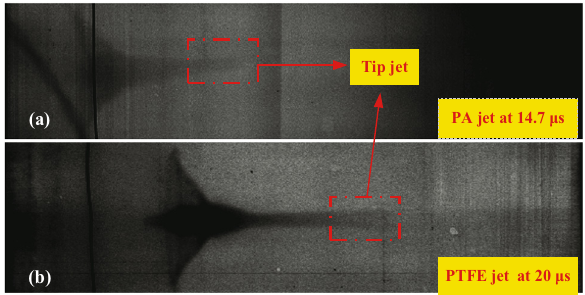
Table 1: Experimental conditions for impact